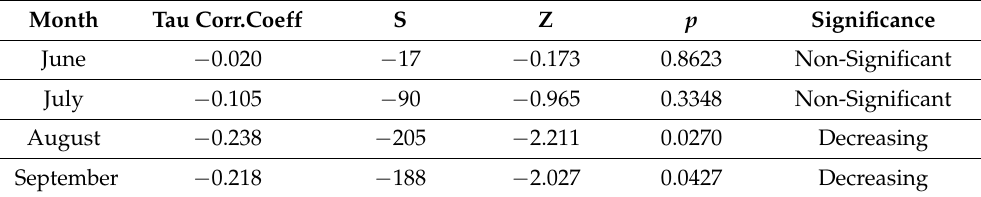
Table 2. Mann Kendall Trend Test of OLR in W/m 2 for ITCZ